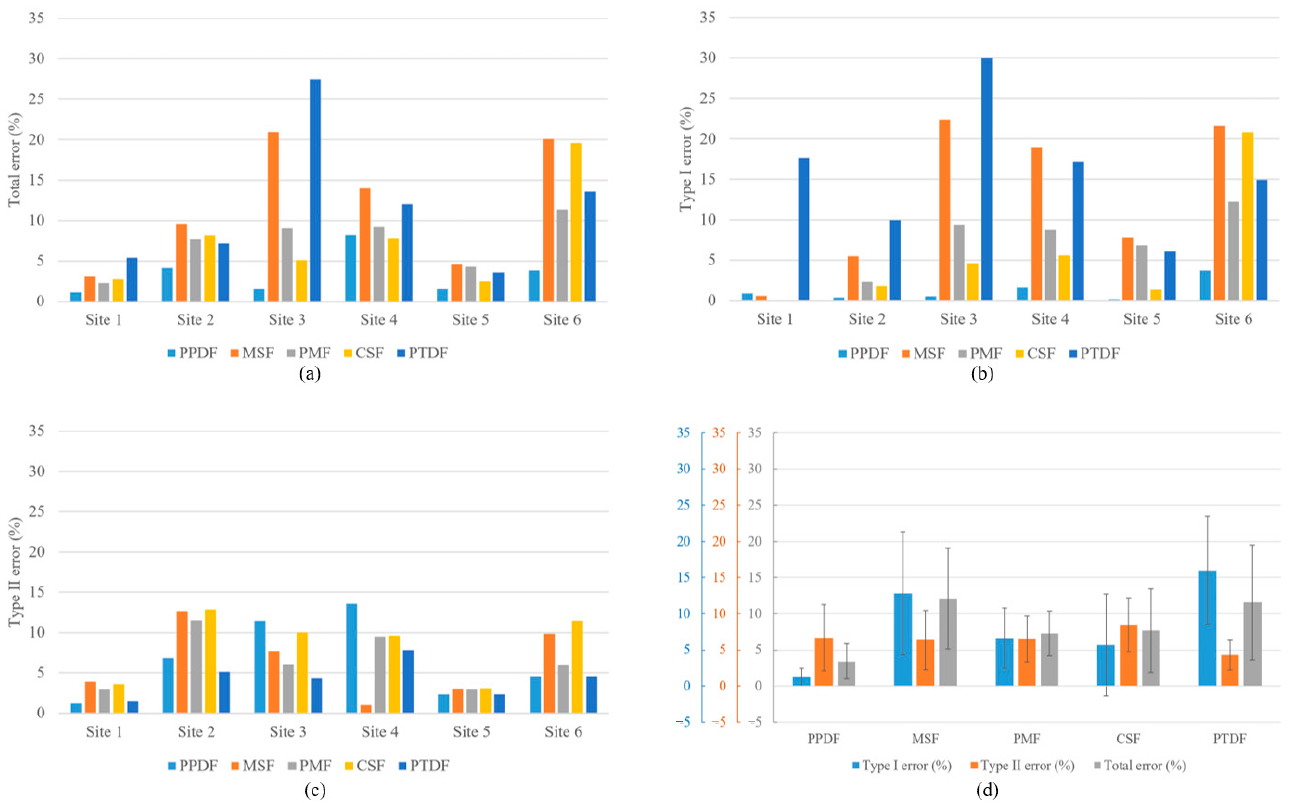
Figure 11. Accuracy comparison of the proposed method and the comparative methods: ( a ) total error, ( b ) type I error, ( c ) type II error, and ( d ) average and standard deviation values of the three errors. MSF, PMF, CSF, and PTDF represent the four comparative methods, i.e., maximum slope filtering, progressive morphology filtering, cloth simulation filtering, and progressive triangular irregular network densification filtering